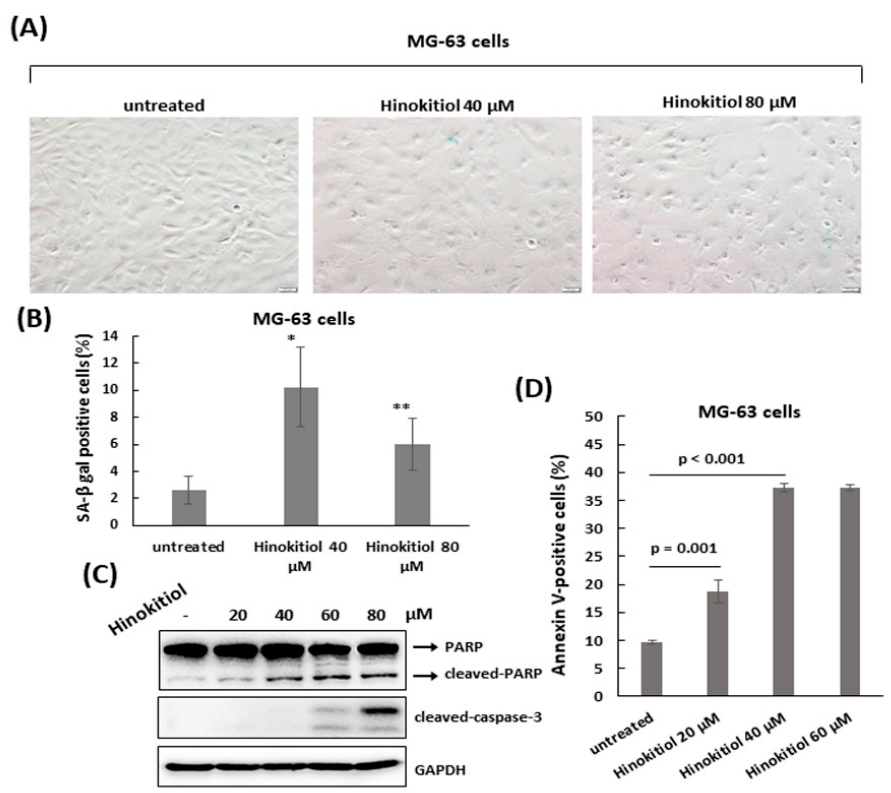
Figure 5. Hinokitiol induces apoptosis in MG-63 cells. ( A ) A small fraction of cells undergoes senescence in hinokitiol-treated MG-63 cells. MG-63 cells were incubated with different dose of hinokitiol for 48 h. Senescent cells were identified by SA- β -gal staining. Quantitative data of SA- β -gal-positive cells (blue color) was revealed ( B ). * p < 0.001, and ** p < 0.01. To detect apoptosis, MG-63 cells that were treated as in ( A ) were analyzed by Western blotting using the indicated antibodies ( C ), or stained with Annexin V and PI, and analyzed using flow cytometry. Quantitative data of Annexin V-positive cells are revealed ( D ).